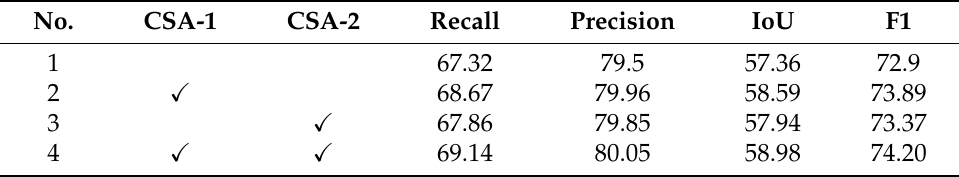
Table 3. Ablation study of the CSA module on the Massachusetts Roads dataset.